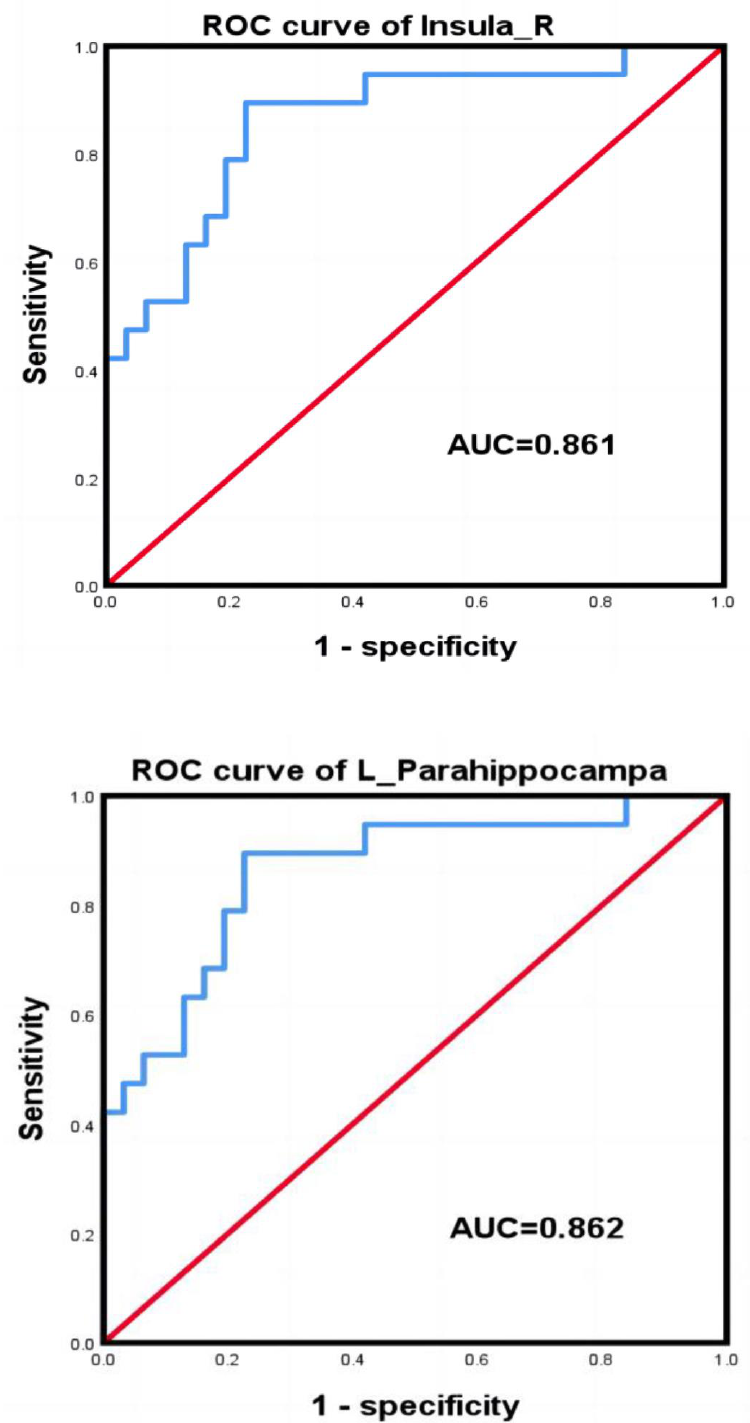
Figure 4. The ROC curves for the right insula and left hippocampus. The AUC for the right insula was 0.861, while the AUC for the left hippocampus was 0.862. Blue line: ROC curve of the right insula and left hippocampus; Red line, reference